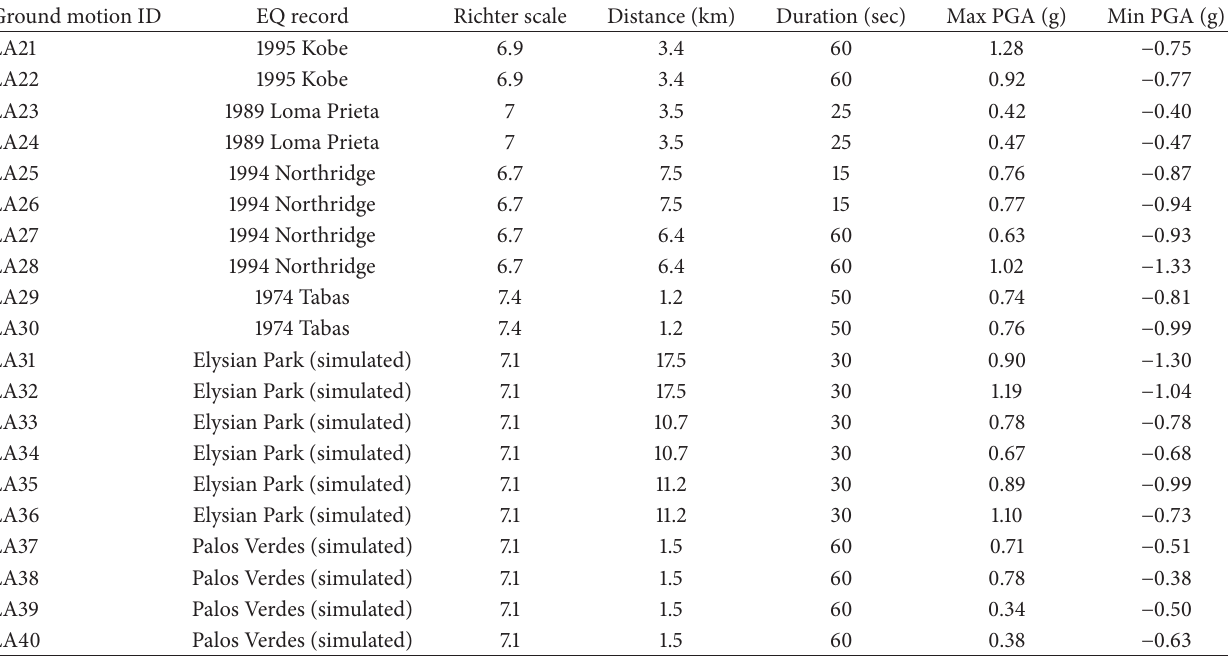
Table 3: Details of Los Angeles ground motions with a probability of exceedance of 2% in 50